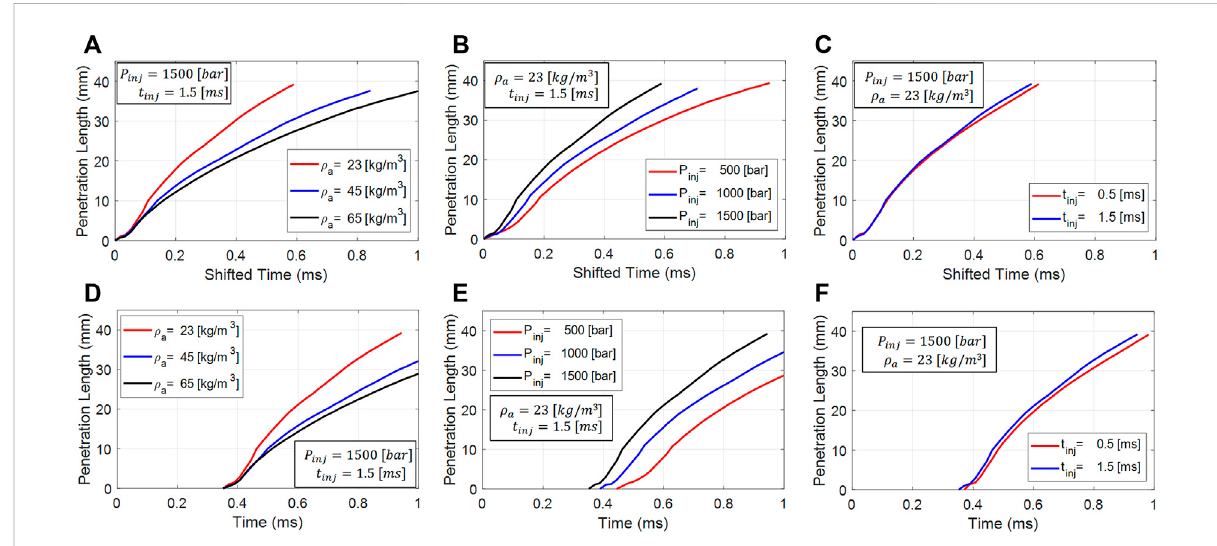
FIGURE 4 The averaged multi-hole spray penetration length as functions of (A – C) shifted time and (D – F) time, at various operating conditions: effect of, ambient density ( ρ a ), fuel injection pressure ( P inj ) , and fuel injection duration ( t inj ),